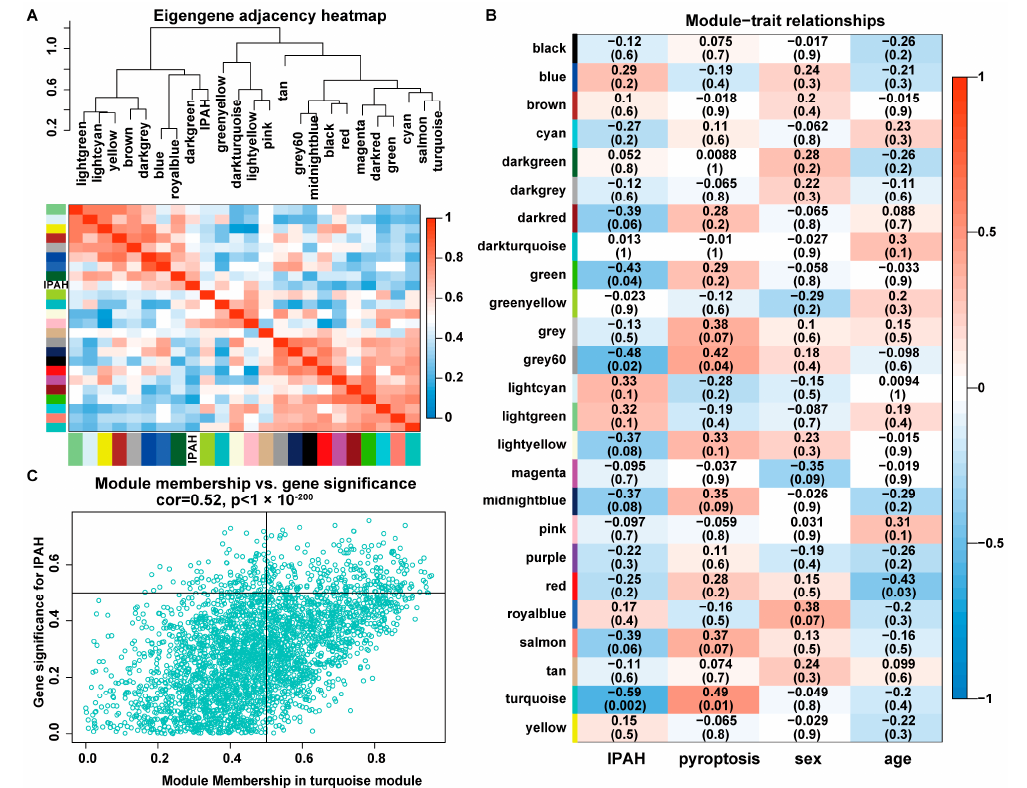
Figure 3. Correlation of modules with IPAH. ( A ) Module feature gene dendrogram and feature gene network heat map analysis of the correlation of the modules generated in WGCNA. ( B ) Correlation analysis of the modules and clinical traits. ( C ) Correlation between MM and GS in the turquoise module.